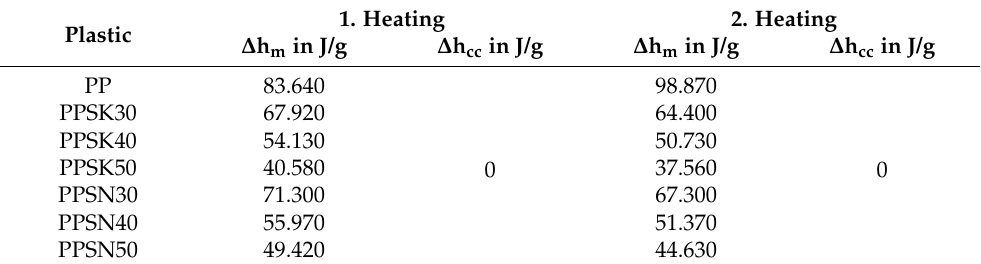
Table 2. Melt enthalpies for PP2 in the first and second heating processes.